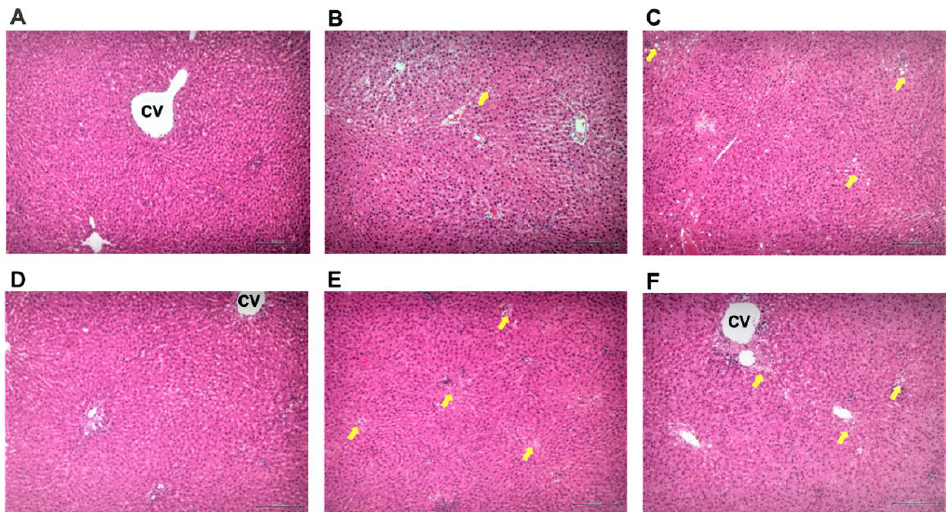
Figure 4. ( A – F ). Effect of pPEM treatment on alcohol-induced hepatic damage in rats using H&E stain- ing of liver tissue: ( A ) normal; ( B ) alcohol; ( C ) silymarin; ( D ) pPEM (L); ( E ) pPEM (M); ( F ) pPEM (H). The experimental groups cotreated with alcohol and silymarin or a low dose of pPEM, a medium dose of pPEM, or a high dose of pPEM are labelled as pPEM (L), pPEM (M), and pPEM (H), respectively. CV, central vein. Yellow arrows indicate fatty